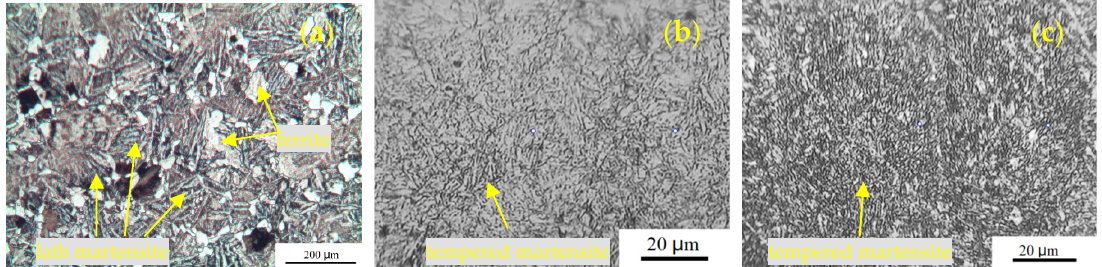
Figure 7. Optical microscope (OM) images for ( a ) base material (BM), ( b ) HD, and ( c ) CF